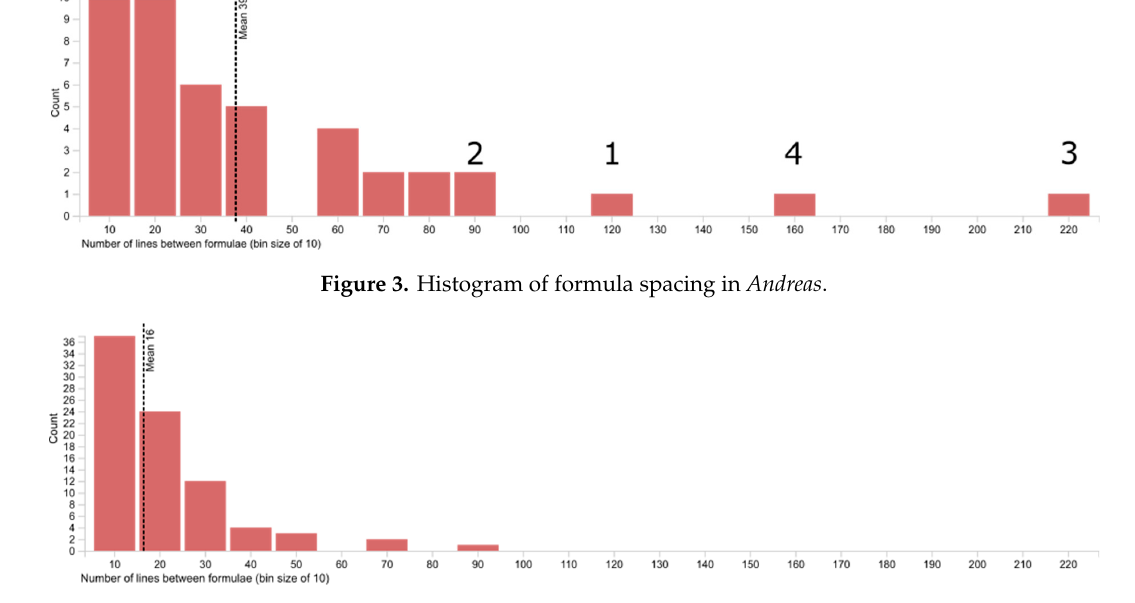
Figure 4. Histogram of formula spacing in Elene .